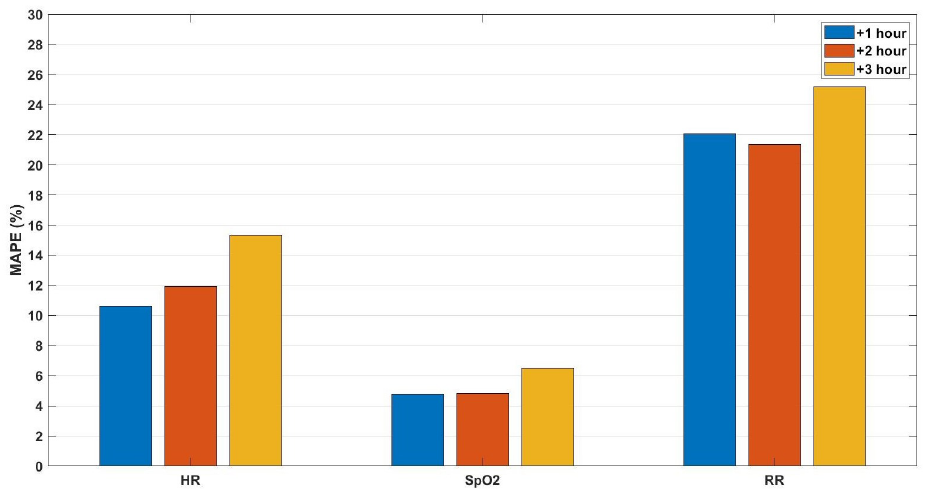
Figure 4. The mean absolute percentage error of the predictions for the upcoming three hours (+1, +2, +3 h) of the vital signs: heart rate (HR), oxygen saturation (SpO 2 ), and respiration rate (RR), respectively, based on hourly to bi-hourly observation rate.